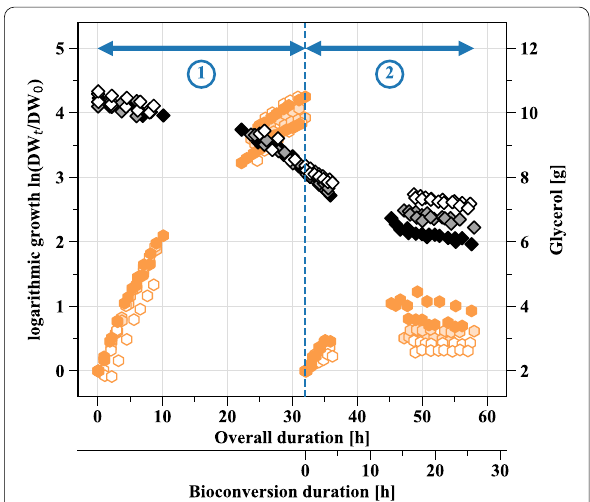
Fig. 3 Growth of Acetobacter sp. CIP 58.66 and glycerol consumption during the sequential process. 1. Primary, batch growth on glycerol; this step is performed in the same conditions for all experiments. 2. Secondary growth during 1,3‑PDO fed‑batch bioconversion, at different pH (4.0, 4.5 or 5.0). For each growth phase, logarithmic growth is calculated on the basis of the initial DW of the concerned phase. For each pH condition, n 2. The initial working volume was = 1.02 L, and the final estimated volumes varied between 0.83 and 0.91 L, depending on